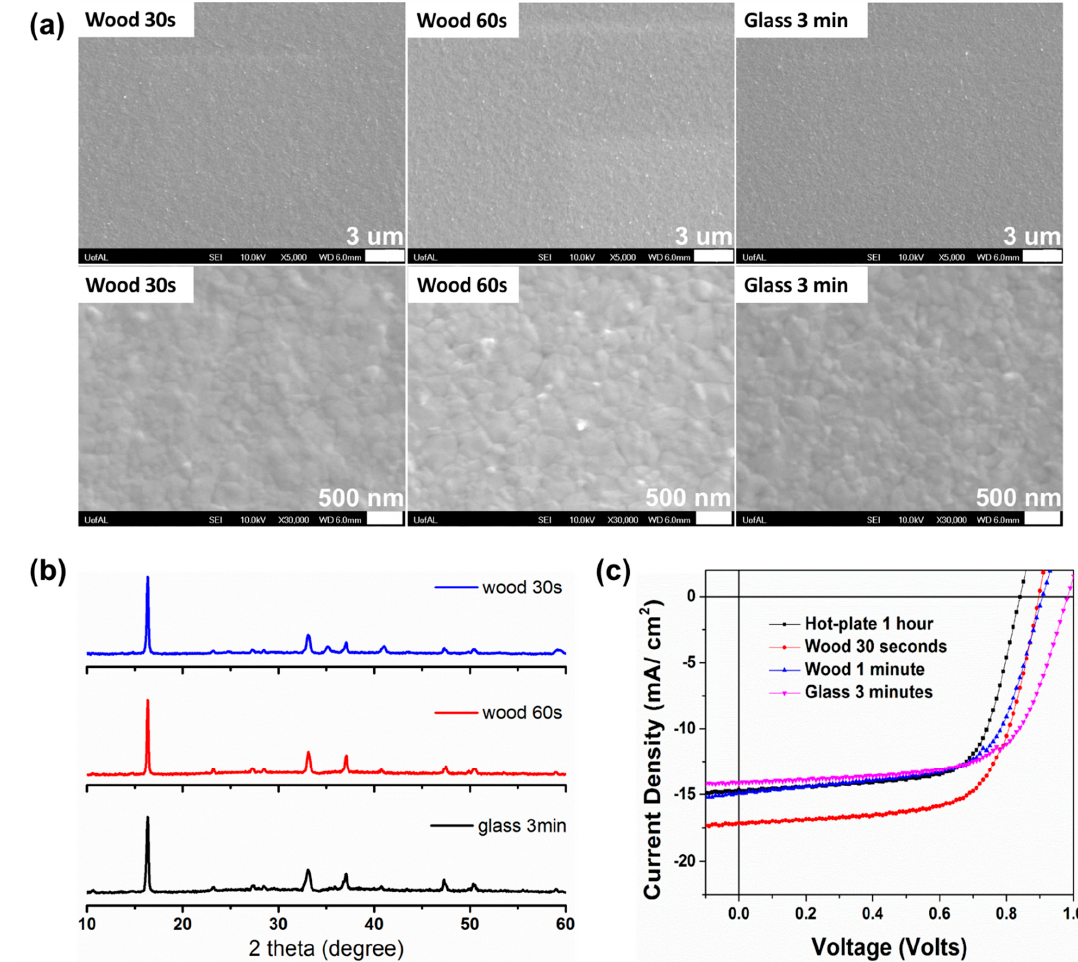
Figure 4. ( a ) SEM monographs show morphologies of perovskite films with addition of PAMAM (1 wt%) under various lamp annealing conditions, including 30 s for samples on wood plate, 60 s also on wood plate, and 3 min on glass sample holder; ( b ) Corresponding XRD spectrum; ( c ) Comparison of J–V characteristics between fast lamp annealing with samples on wood and glass holders and traditional hotplate annealing.